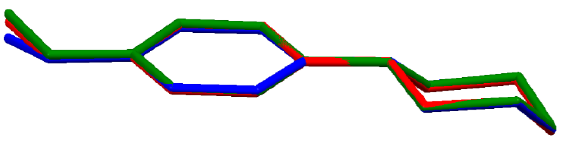
Figure 2. Superimposed molecular structures of cations: (I)-red, (II)-green and (III)-blue.